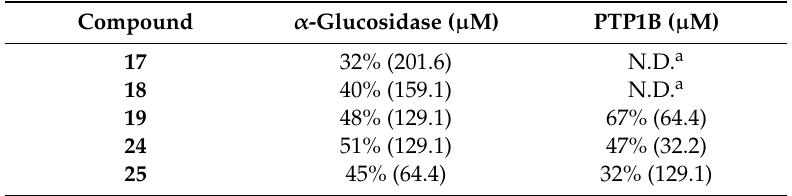
Table 6. Percentage inhibition of 17 – 19 , 24 and 25 against α -glucosidase and PTP1B at the concentration shown in brackets.